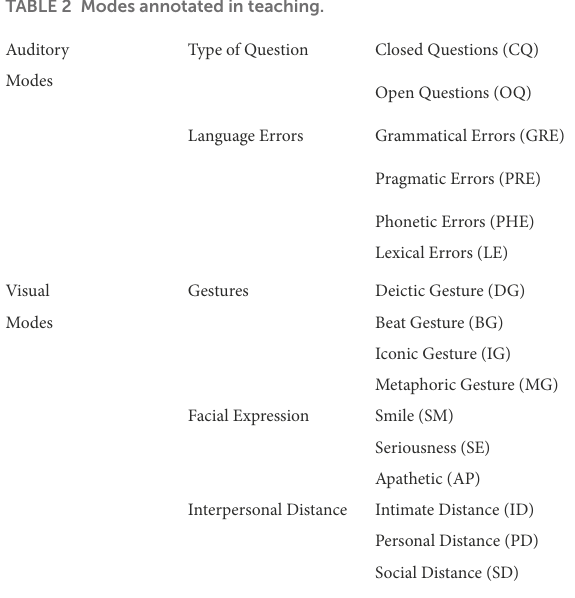
TABLE 2 Modes annotated in